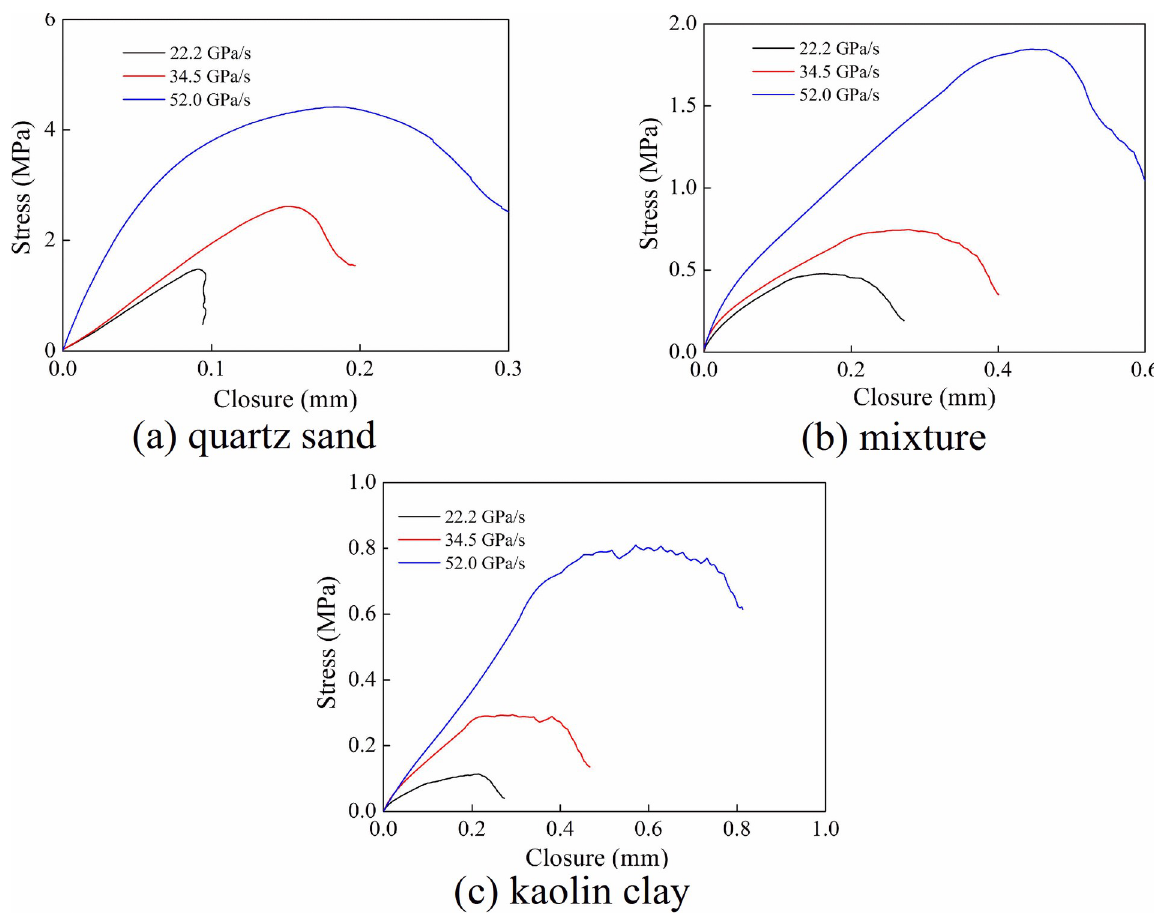
Fig 13. Stress-closure relationship at different loading rates ( d = 3 mm). (a) quartz sand (b) mixture (c) kaolin